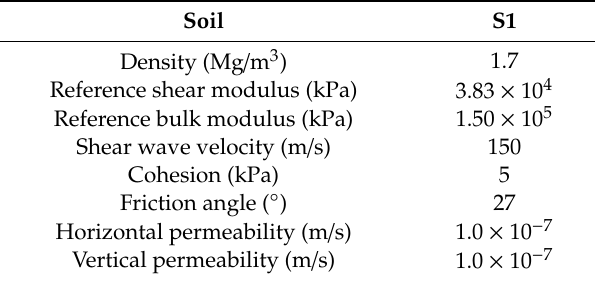
Table 4. Infill soil characteristics.